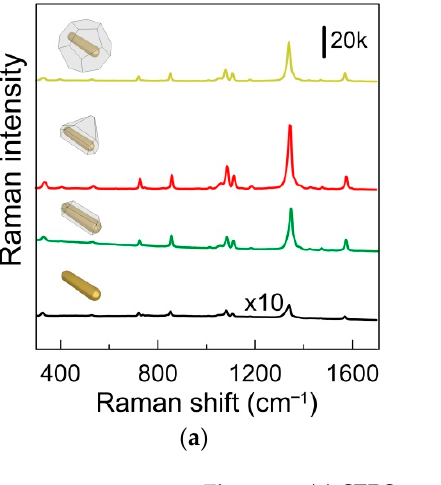
Figure 3. ( a ) SERS spectra of Au@Ag core–shell nanorods with embedded NBT. The nanoparticles were obtained using Ag-to-Au molar ratios 5 (yellow curve), 2.5 (red curve), and 1.25 (green curve). The black curve corresponds to SERS spectra of the AuNRs functionalized with NBT; ( b ) the dependence of SERS intensity of NO 2 vibration on the Ag/Au molar ratio.